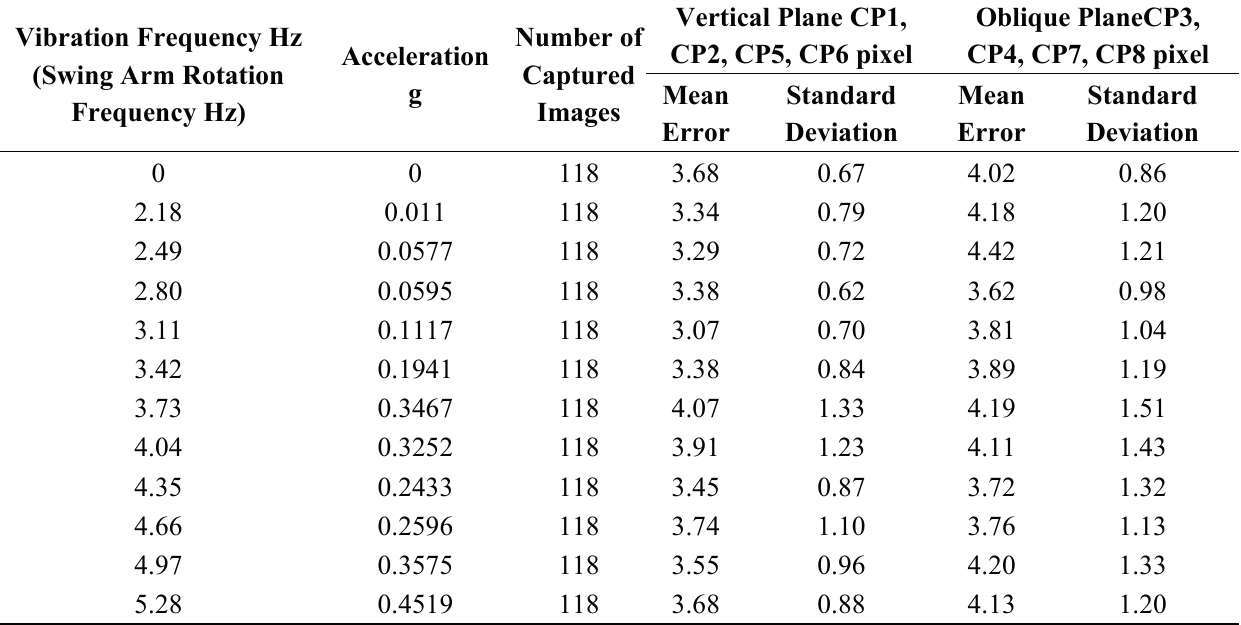
Table 4. Results of the third